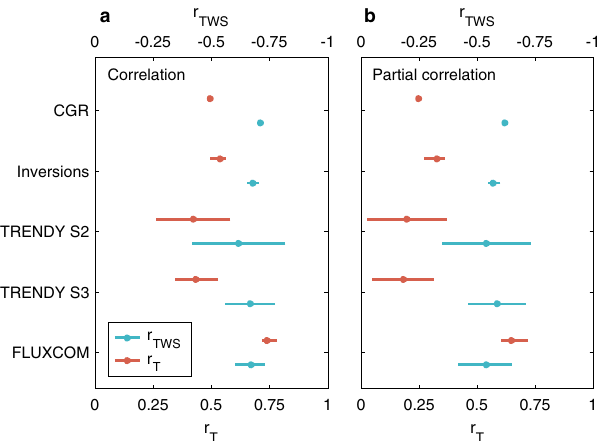
Fig. 1 Relationships between the interannual variability (IAV) of global net ecosystem exchange (NEE) and terrestrial water storage (TWS) or temperature (T). The correlation ( a ) and partial correlation ( b ) between the IAV of global NEE and the IAVs of global mean TWS (r TWS ) or T (r T ) are estimated. The IAV of CO 2 growth rate (CGR) is a proxy of the IAV of global NEE. The NEE is also estimated by atmospheric inversions, dynamic global vegetation models (DGVMs) from the TRENDY project in simulation S2 (NEE output; see Methods) and in simulation S3 (NBP output with the opposite sign; see Methods), and FLUXCOM models. Cyan (red) circles indicate the correlations between global NEE and TWS (T). Error bars for atmospheric inversions and FLUXCOM models indicate the range of models, while the error bars for DGVMs from the TRENDY project are the 1- σ inter-model spread. The NEE derived from FLUXCOM models and DGVMs from the TRENDY project in S2 (NEE output) do not include disturbances (e.g., fi re emissions), but the NEE in atmospheric inversions and DGVMs from the TRENDY project in S3 (NBP output with the opposite sign) include disturbances. A larger NEE indicates less net carbon